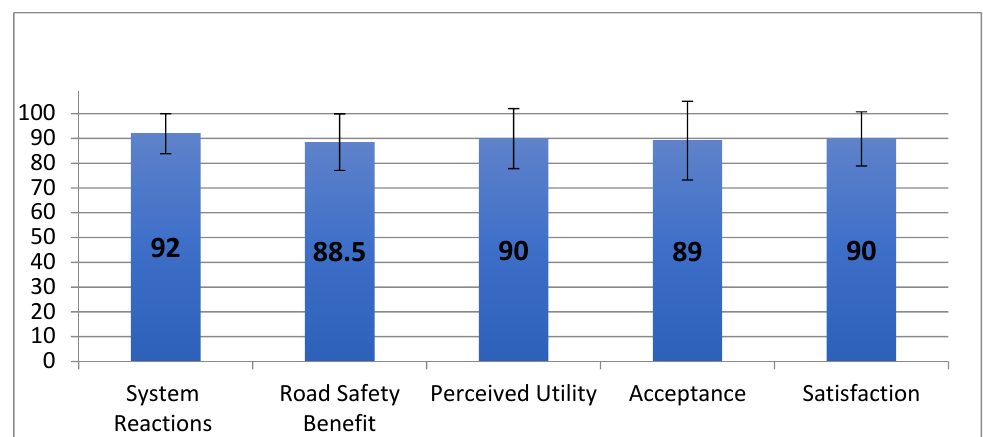
Figure 9. Users’ evaluations of the HMT manager performances.